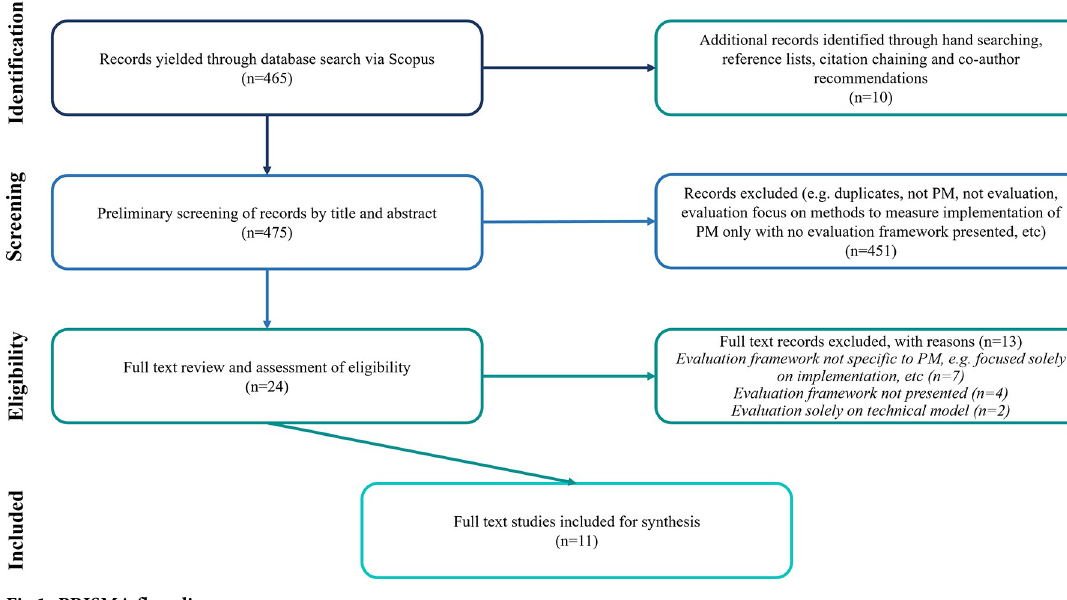
Fig 1. PRISMA flow diagram.